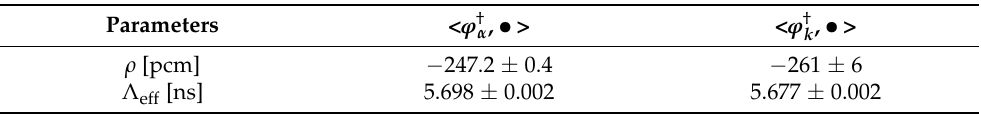
Effective kinetics parameters of Problem I, super-critical configuration without delayed